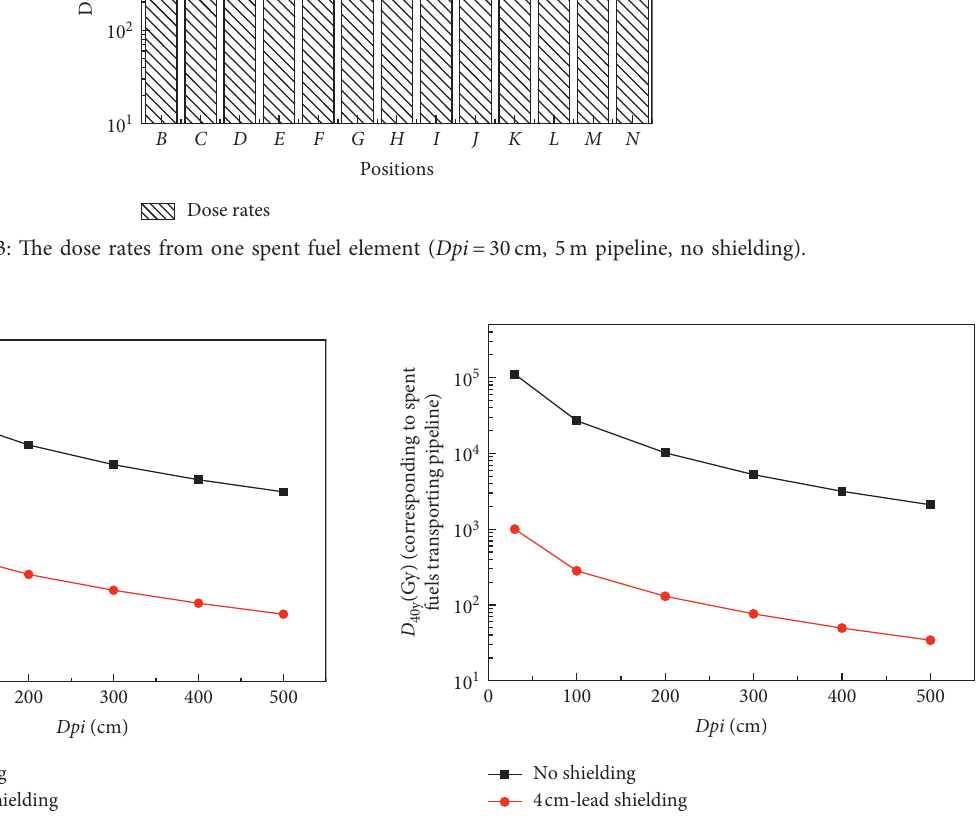
Figure 4: _ D at different Dpi positions for a 5m